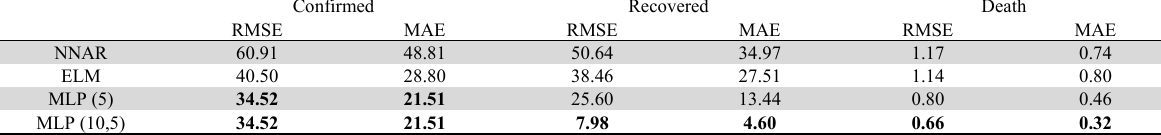
The value of metric evaluation using the NNAR, ELM, and MLP models Confirmed